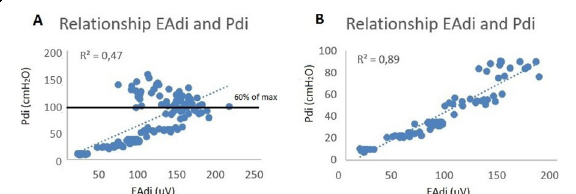
Fig. 1 (abstract 001504). Relationship between EAdi and Pdi within one subject. In panel B, breaths above 60% of maximum have been